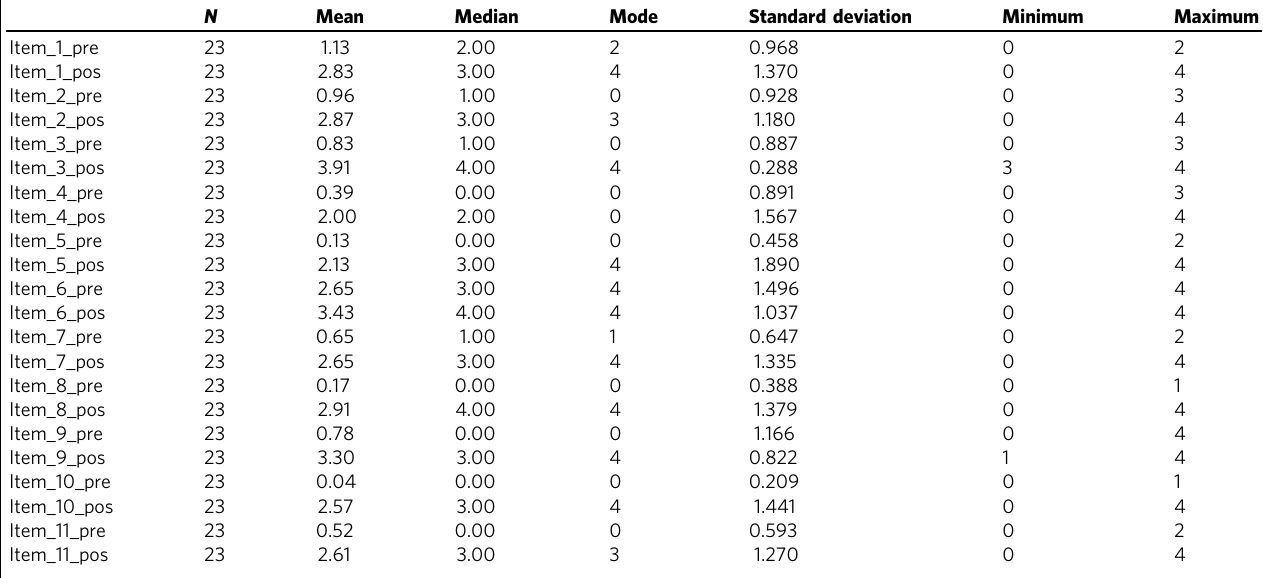
Table 3 Descriptive statistics of the experimental group in the pretest and posttest.